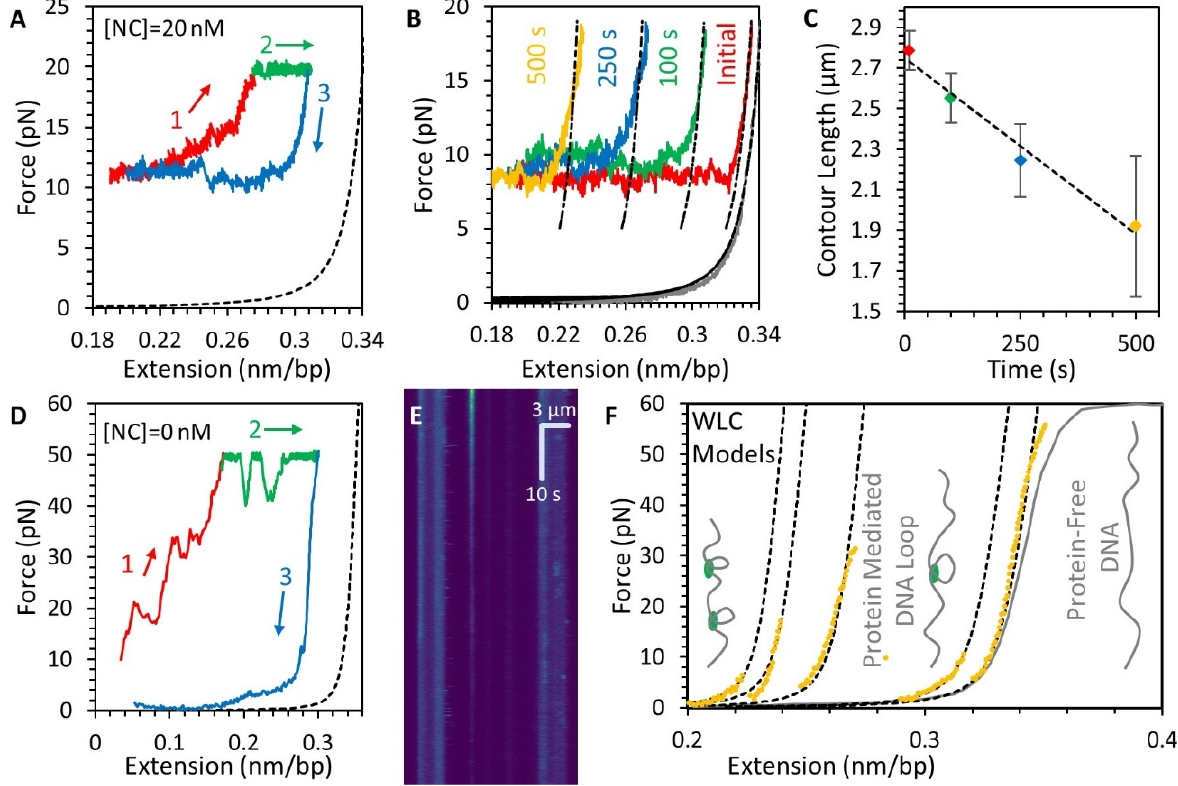
Figure 6. Stability and structure of the DNA-NC complex. ( A ) After the -NC-DNA condensate is formed (as shown in Figures 3–5), the complex is re-stretched (1, red), displaying large hysteresis, indicating that NC compaction is not reversible. High force can partially decompact the DNA (2, green) and the force plateau reappears when the extension of the DNA is decreased (3, blue). Dashed line shows protein-free DNA for reference. ( B ) When the compacted DNA substrate is left incubating with NC (20 nM), the NC-DNA complex is progressively shortened, as shown by representative force-extension curves with different incubation times (colored lines). ( C ) The contour length of the NC-DNA complex decreases as incubation time is increased. ( D ) Re-stretching the NC-DNA complex immediately after free protein is removed from the system still requires high applied force for decompaction (1, red and 2, green), but the majority of NC is dissociated from the DNA as the release of the DNA extension no longer displays the force plateau caused by NC-mediated compaction (blue). Dashed line shows protein-free DNA for reference ( E ) Kymograph showing globules of fluorescently-labeled NC initially formed at low DNA tension (top) dissipating while the DNA is held at a tension of 20 pN (same condition as green line in panel ( D )). Horizontal axis shows fluorescence intensity along axis of stretched DNA with large stripes on left and right displaying bead autofluorescence and bright spots in between indicating the locations of NC globules. Vertical axis shows the globules fading but not disappearing entirely over 10 s timescale, indicating partial dissociation. ( F ) Re-stretching the NC-DNA complex again, still in the absence of free protein, follows WLC models with reduced contour length (dashed lines). Several sudden abrupt increases in contour length (shifting to the right) occur, consistent with the sudden breaking of large DNA loops, until the DNA reaches the extended length of protein free DNA (gray line), as illustrated by inset cartoons.